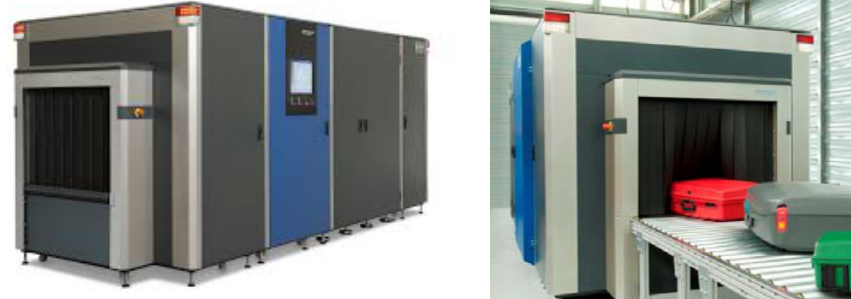
Figure 13 – Stationary device HI-SCAN 10080 XCT Рис . 13 – Стационарное устройство HI-SCAN 10080